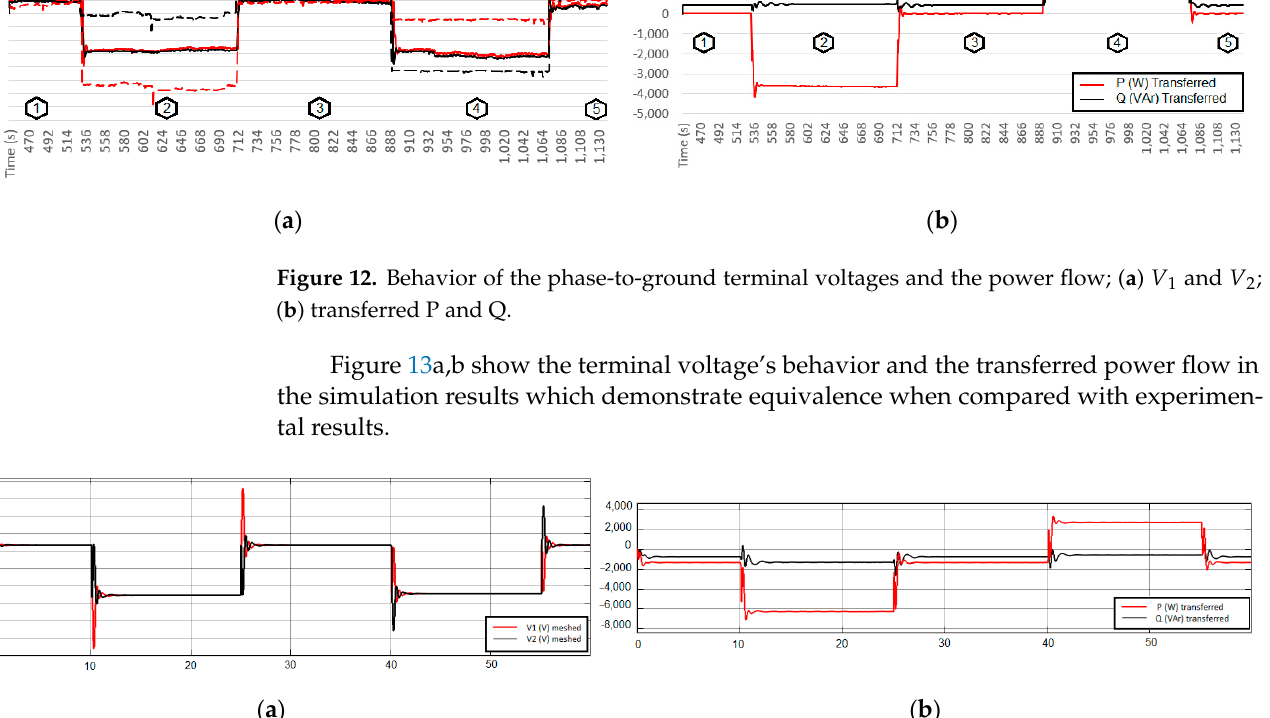
( b ) Figure 14. Phasors before and after power flow manipulation; ( a ) R 1 insertion stage–without the converter operation; ( b ) R 1 insertion stage–with the converter operation.